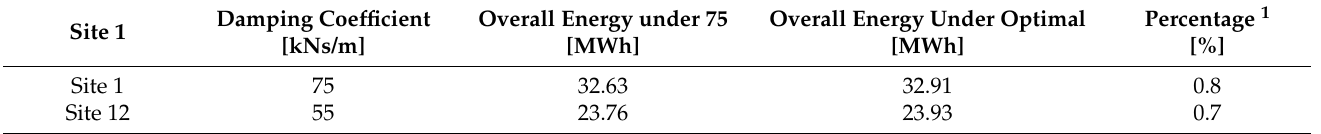
Table 7. A comparison of the overall annual energy between optimal control and constant